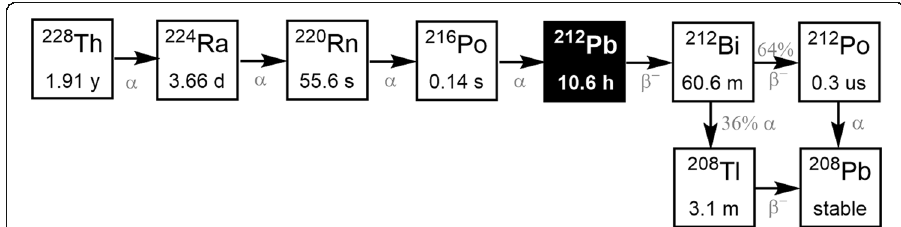
Fig. 1 Decay scheme of 228 Th to 212 Pb and stable 208